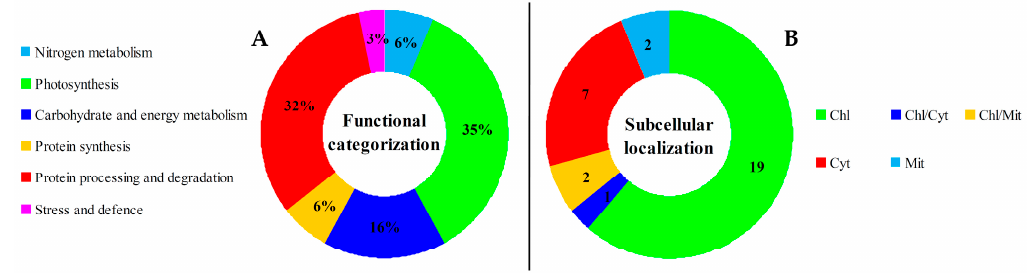
Figure 6. Functional categorization and subcellular localization of the differentially expressed proteins (DEPs) from various leaf regions at different development stages of Hosta “Gold Standard”. ( A ) A total of 31 DEPs were classified into six functional categories. The percentage of proteins in different functional categories is shown in the pie; ( B ) Subcellular localization categories of the identified proteins. The numbers of proteins with different locations are shown. Chl: Chloroplast; Cyt: Cytoplasm; Mit: Mitochondria.